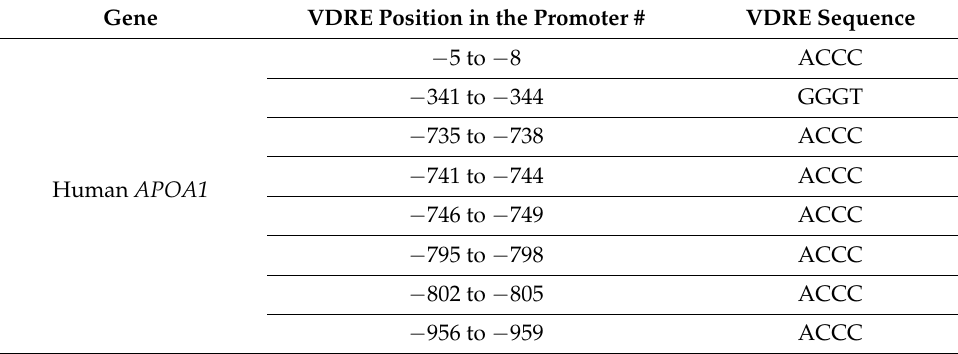
Table 7. VDREs in the promoter sequence of the human APOA1 gene. Gene VDRE Position in the Promoter # VDRE Sequence − 5 to − 8